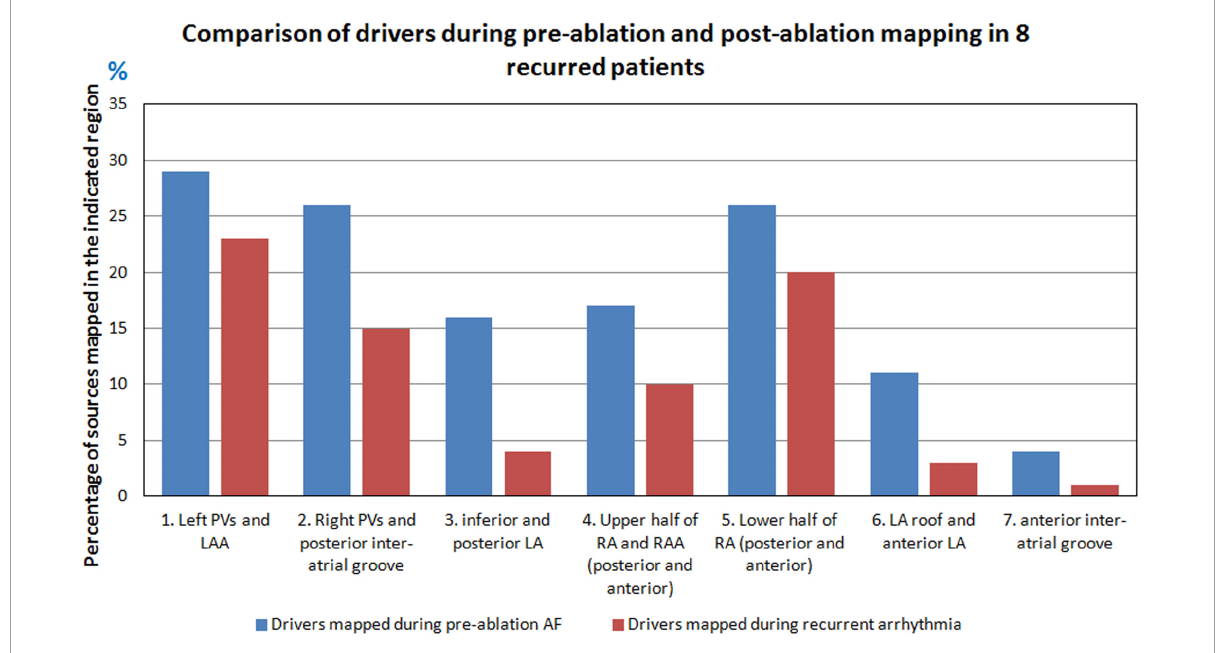
FIGURE7 Comparison of pre- and post-ablation AF drivers in the eight patients with recurrent AF.